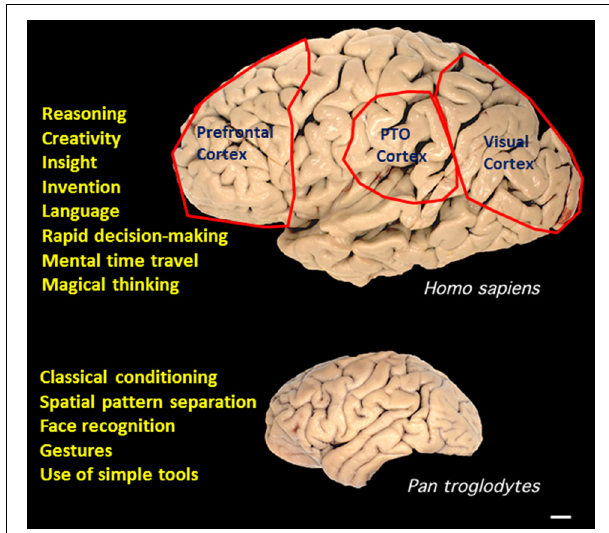
FIGURE 1 | Superior pattern processing (SPP) capabilities of the human brain evolved in association with expansion of the cerebral cortex. A comparison of the gross anatomy of the brains of humans and chimpanzees ( Pan troglodytes ) reveals considerable expansion of three regions in humans, the prefrontal cortex, the visual cortex, and the parietal—temporal—occipital juncture (PTO). Examples of SPP capabilities of humans are listed next to the human brain. Examples of pattern processing capabilities of great apes are listed adjacent to the image of the chimpanzee brain. Source of brain images is Wikimedia Commons. Scale bar,